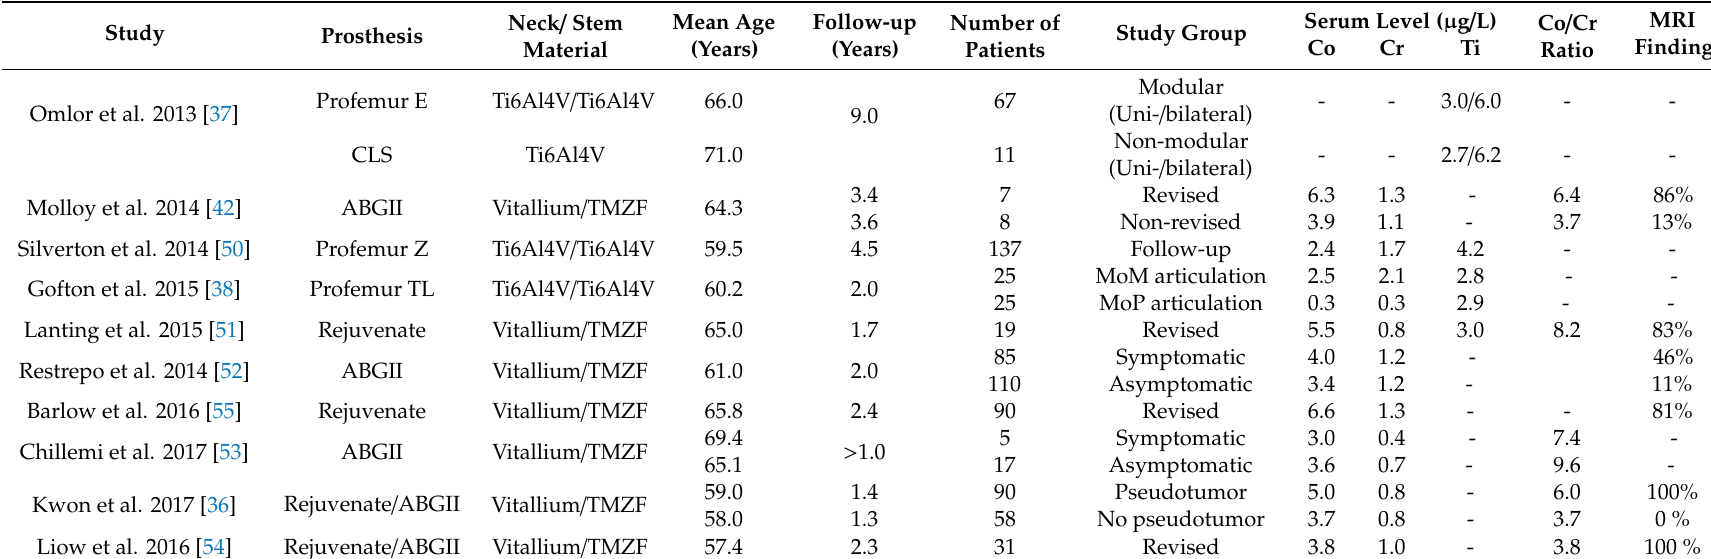
Table 1. Literature overview about clinical cohorts with dual taper neck